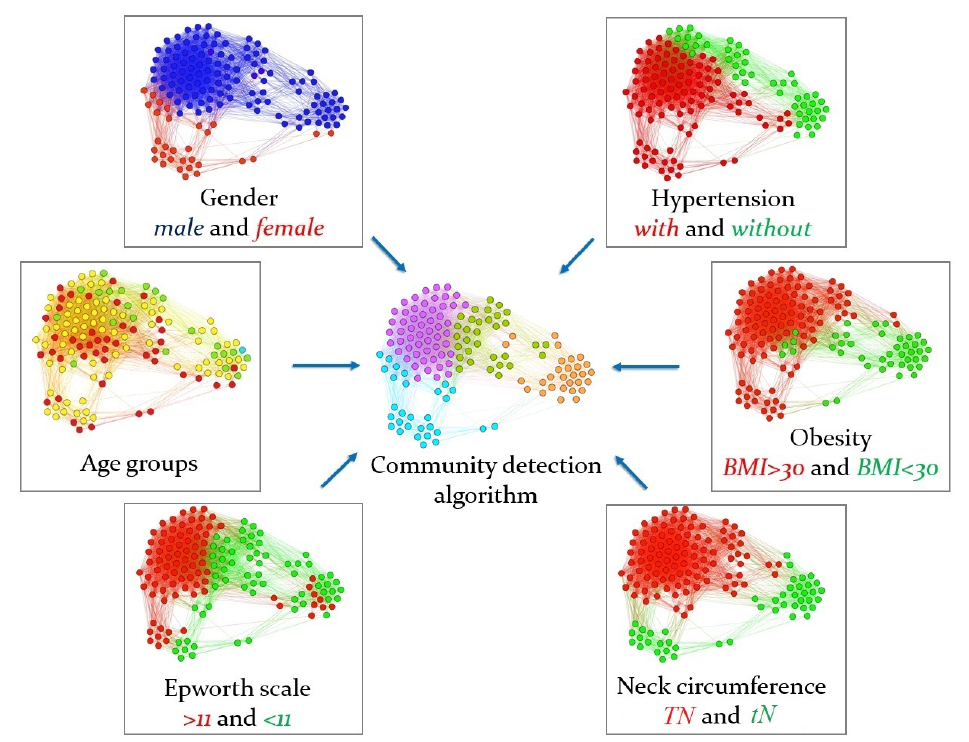
Figure 3. The network of 145 patients with overnight CPAP treatment shows the mapping of the six measurements (age, gender, blood pressure, BMI, Epworth scale, and neck circumference) that are relevant for the four patient communities detected for OSA (central panel). The four communities ( C 1 —magenta, C 2 —olive, C 3 —orange, C 4 —cyan) emerged from the modeled risk compatibility between patients and were used to study the associations between patient risk factors and CPAP treatment response. Table 2. Percentages of patients from each community ( C 1 − C 4 ) categorized into each of the four OSA severity classes ( norm, mild, mod, sev ) before and after one-night CPAP treatment. Before